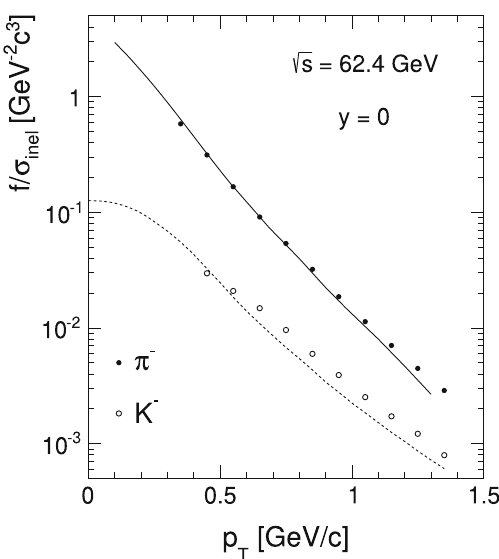
√ Fig. 74 Cross sections f /σ inel at s = 64.2 GeV [39] as a function of p T at y = 0, full circles for π − , open circles for K − . The global interpolation at this energy is given by the full line for π − , the ISR data for K − [49] by the broken